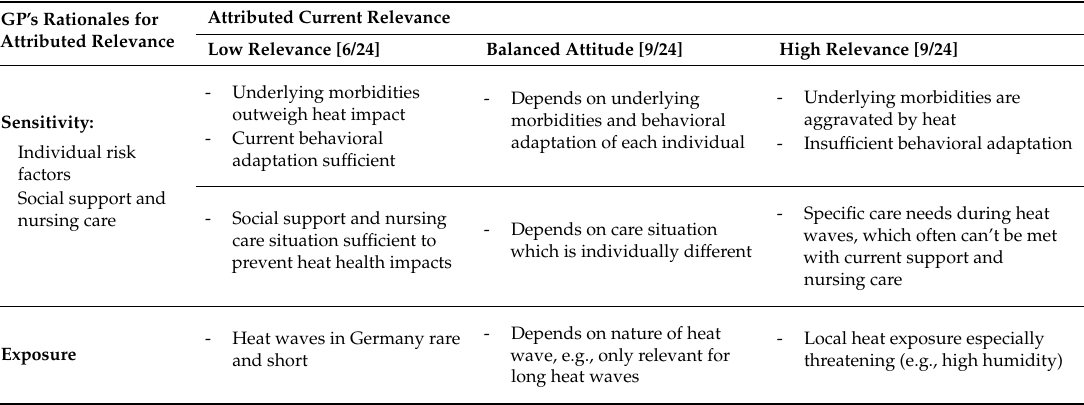
Table 2. GPs’ perceptions of current relevance of heat health impacts on the